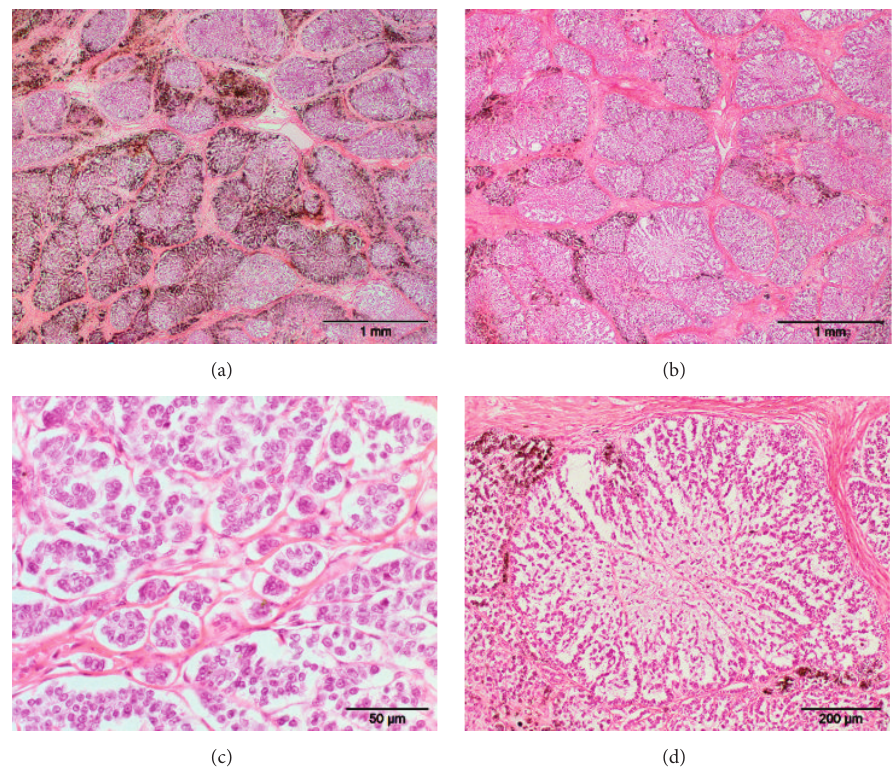
Figure 3: Basal cell tumor in a Namibian cheetah. (a) Area of heavily pigmented dark brown tumor lobules and (b) tumor lobules sparsely pigmented. (c) Tumor cells oriented in cords and nests separated by thin collagen. (d) Tumor nodule with cells with indistinct cell borders delineated by fine connective tissue. HE